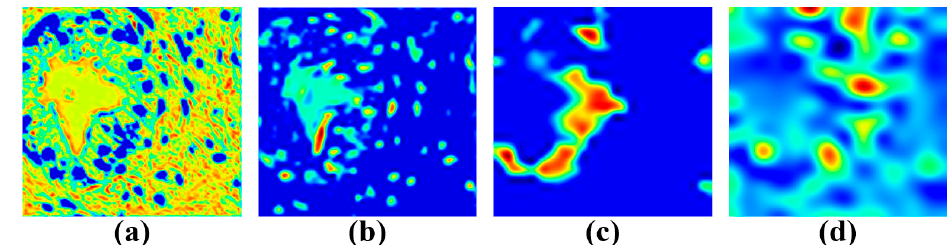
Figure 13. Visualizations of class activation maps generated from model 2, created using different numbers of filters. Outputs of ( a ) first convolutional, ( b ) second convolutional, ( c ) third convolutional, and ( d ) classification blocks. Colors indicate the most relevant regions for predicting the class of these histopathology images, as detected by the convolutional neural network.